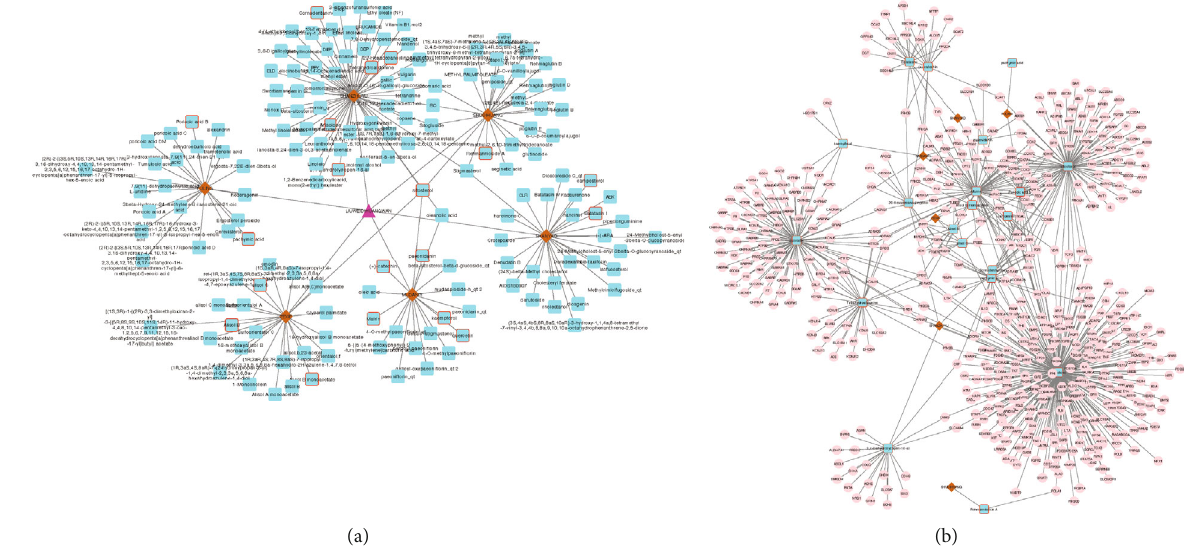
Figure 3: (a) LWDHW-compound network. (b) LWDHW-compound – target network. The purple triangle represents the LWDHW formulation. The brown diamonds represent the herbs, and the blue squares indicate the constituent compounds. The blue squares with the red frames indicate the main ingredients. Pink circles represent the targets. Table 1: The active compounds of Liu Wei Di Huang